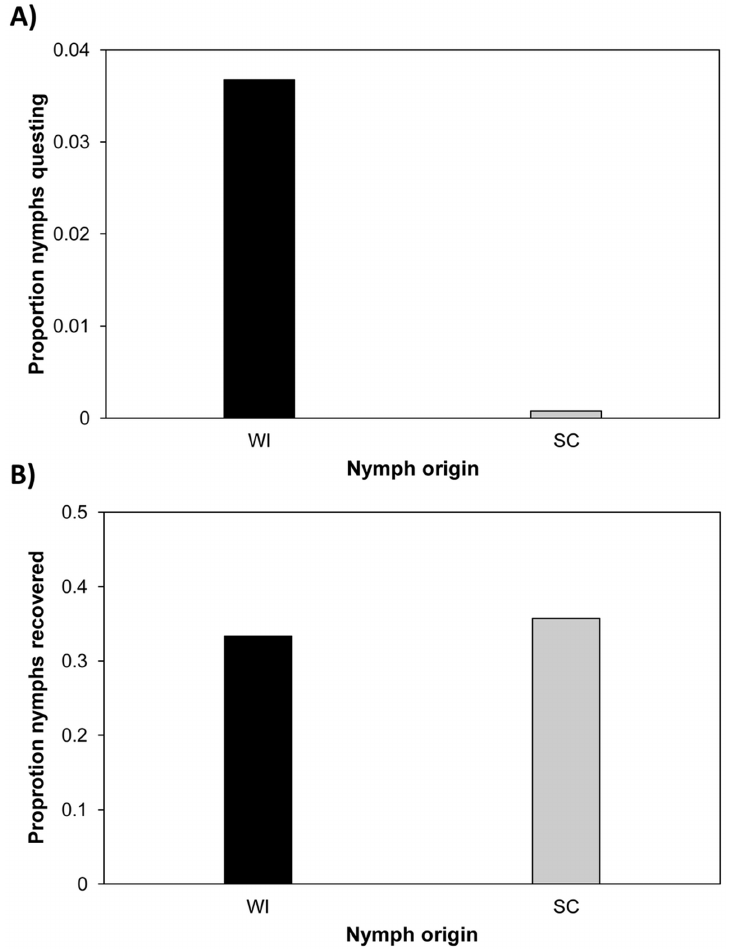
Fig 1. Questing behavior data from experimental arenas in Wisconsin (WI) during June-July 2011. (A) Proportion of nymphs from each origin observed questing on stems. A higher proportion of WI nymphs were observed on the stems compared to the South Carolina (SC) nymphs. (B) Proportion of nymphs from each origin recovered when arenas were depopulated on July 30, 2011. Recovery rates were similar for nymphs from both origins. The data used in this figure are given in S1 Data (A) and S2 Data